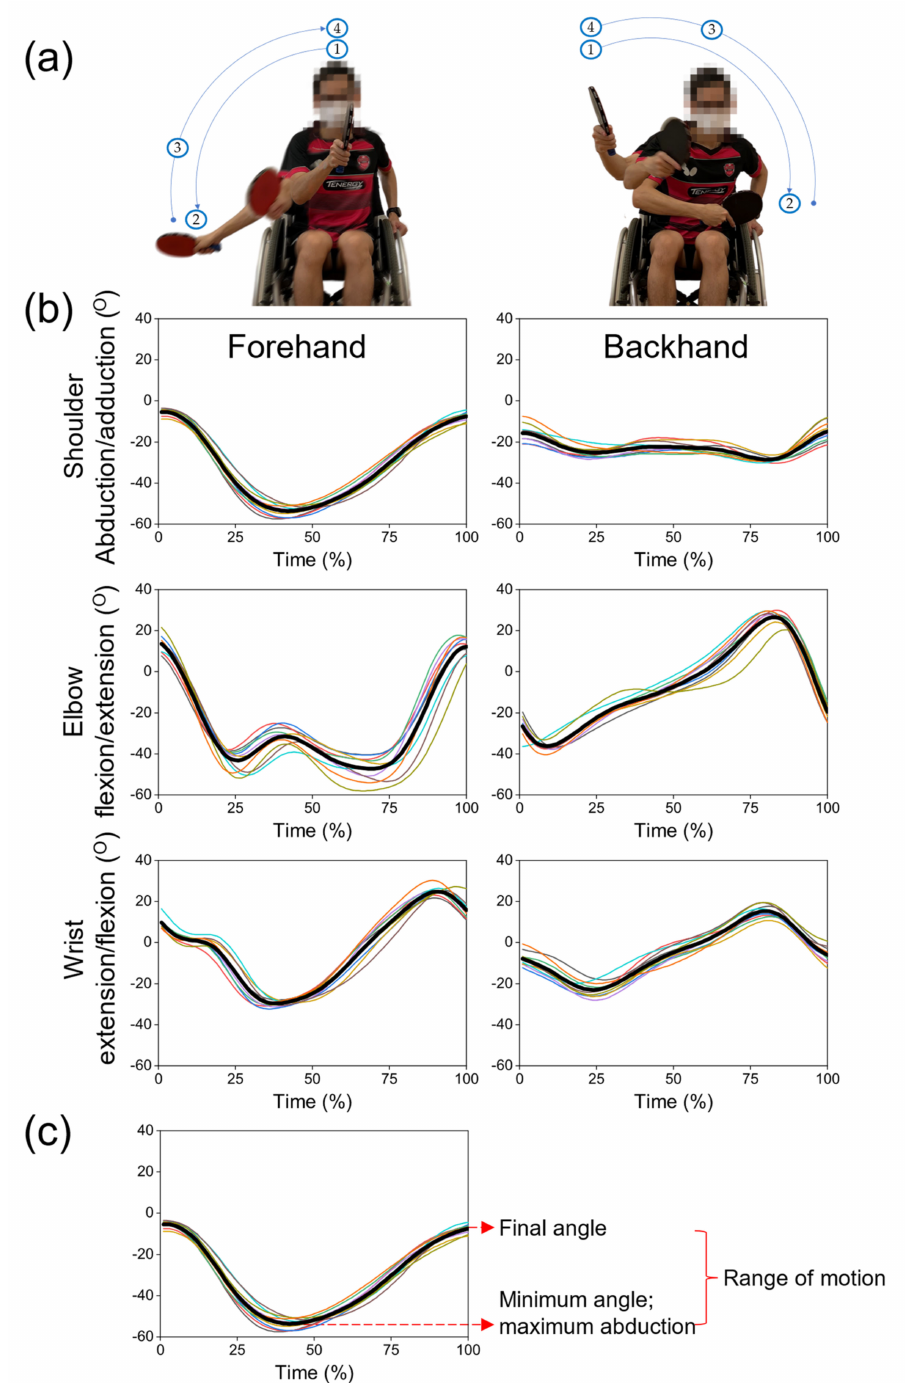
Figure 3. ( a ) All participants performed the forehand ( left ) and backhand ( right ) topspin drives where positions 1 to 2 refer to the preparation phase, positions 2 to 3 refer to the execution phase, and position 3 to 4 refer to the follow-through phase; ( b ) time-normalized joint angles for forehand and backhand topspin drive where each figure presents 10 analyzed trials for one participant with the solid black line representing the mean value; ( c ) extracting key variables of interest for each drive where minimum angle, final angle, and range of motion (ROM) for each joint are